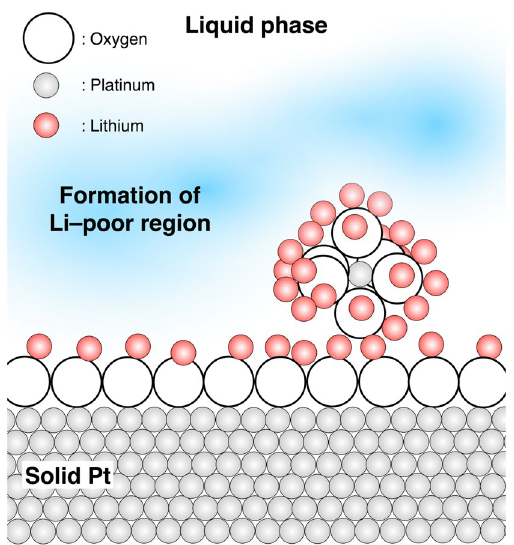
Figure 4. Schematic of local structure of platinum atoms in the supercooled liquid composed of lithium disilicate. It is assumed that the platinum atoms near the liquid/solid interface are partly ionized as Pt 4 + . Lithium cations are segregated in the vicinity of the platinum atoms. Subsequently, a lithium-poor region forms.